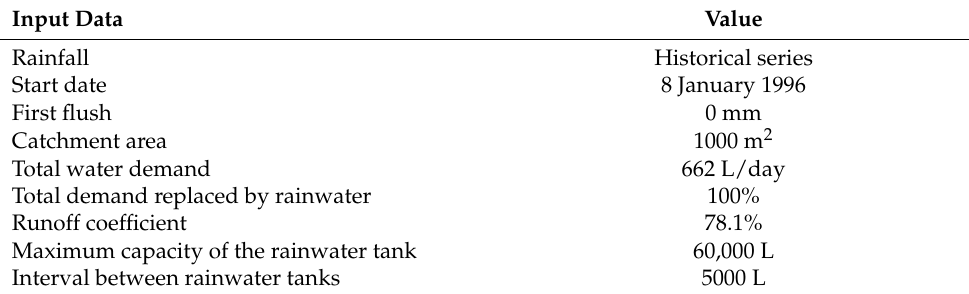
Table 2. Input data for the computer simulations.